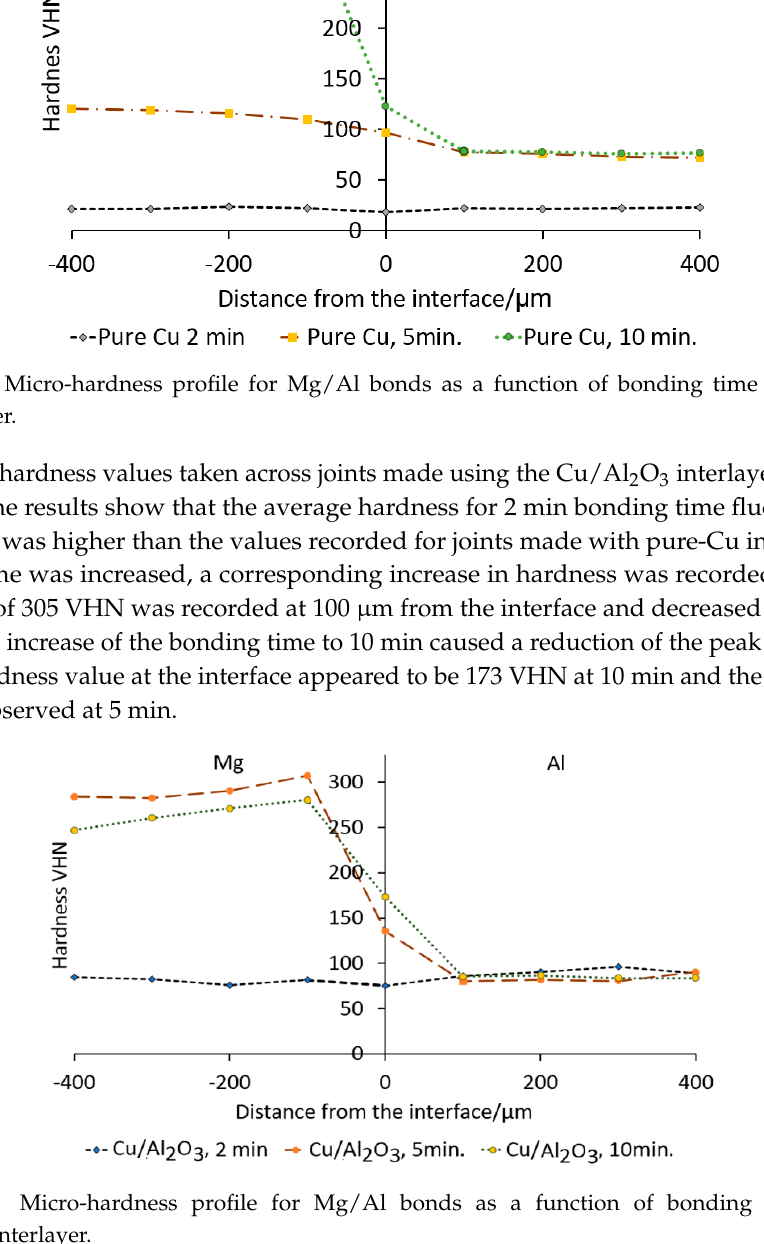
Figure 10. ( A ) SEM micrograph of Mg/Al bonded for 10 min using Cu/Al 2 O 3 interlayer. ( B ) Detailed view of the interface.